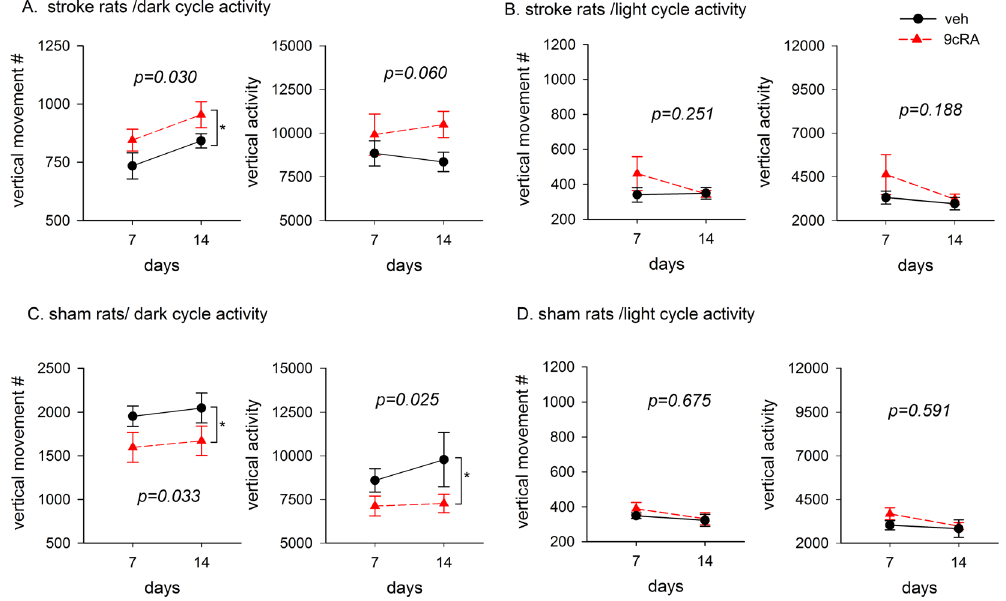
Figure 2. Posttreatment with 9cRA improved vertical movements during the dark cycle in stroke rats. ( A and B ) Stroke rats (n = 13) received intranasal treatment with 9cRA or vehicle from days 3 to 13. Animals were kept in a 12-hour light (sleep) and 12-hour dark (awake) cycle during behavioral testing on days 7 and 14. ( A ) In the dark cycle, 9cRA treatment significantly increased vertical movement numbers (p = 0.030) while marginally improving vertical activity (p = 0.060, 2-way ANOVA). ( B ) In the light cycle, 9cRA did not significantly alter vertical movement number and activity. ( C and D ) Another 13 rats received sham surgery on day 0 and then were treated with 9cRA or vehicle. ( C ) In the dark cycle, 9cRA significantly reduced vertical movement number (p = 0.033) and activity (p = 0.025). ( D ) These behavioral parameters were not altered by 9cRA in the light cycle. ( * Significant